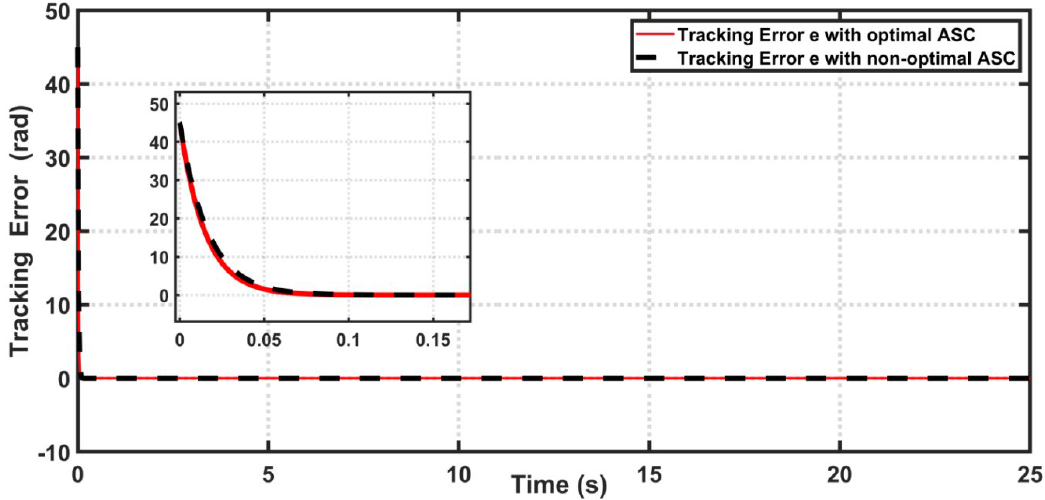
Figure 9. The responses of tracking errors based on non-optimal and optimal ASC.